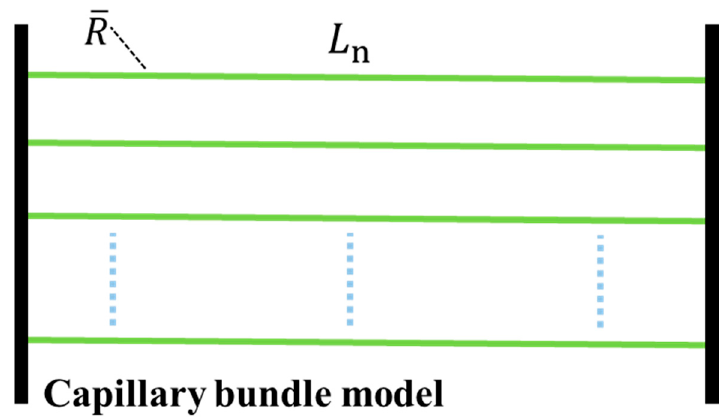
Figure 2. Capillary bundle model.